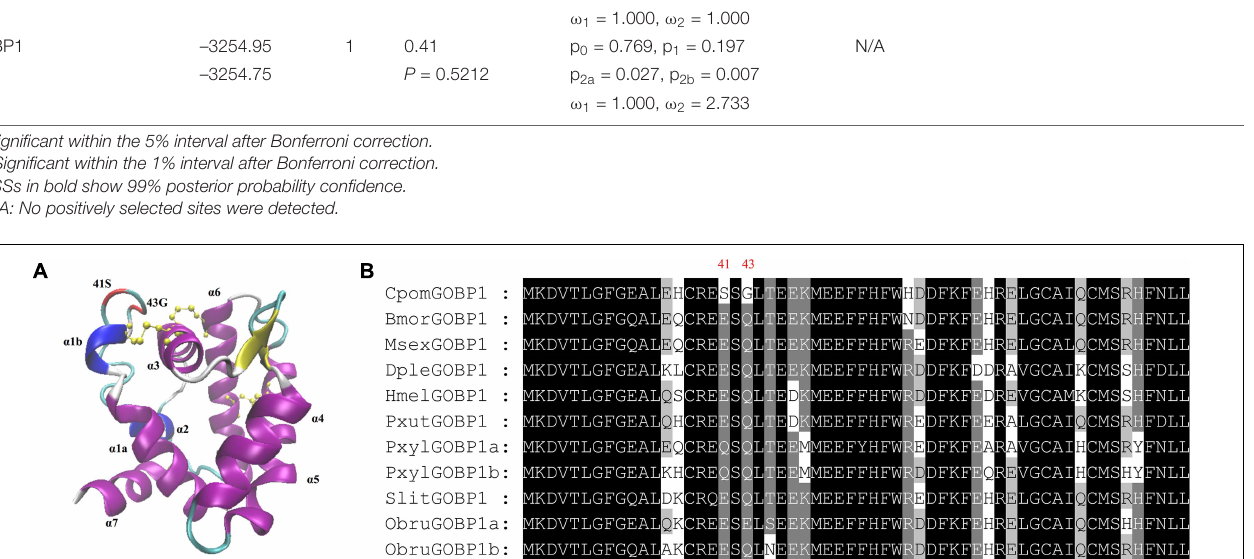
and functional requirements for each species. A study in B.